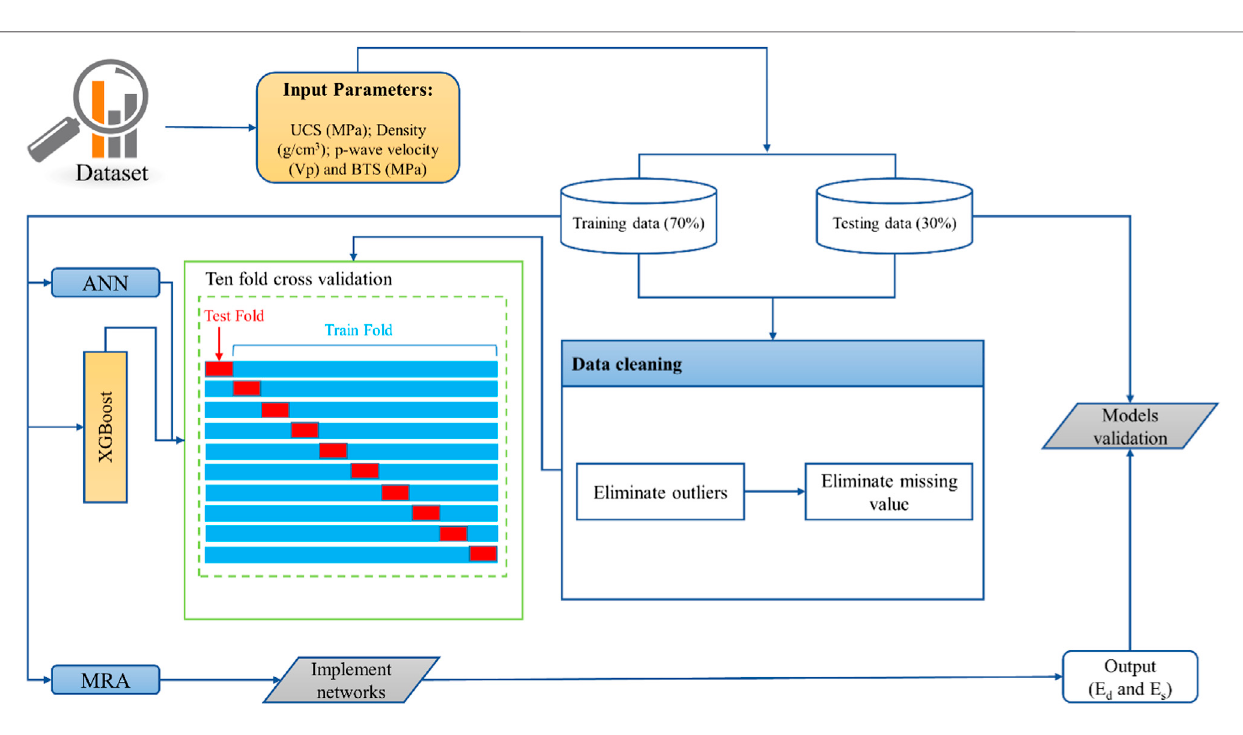
FIGURE 3 | Flow chart of the